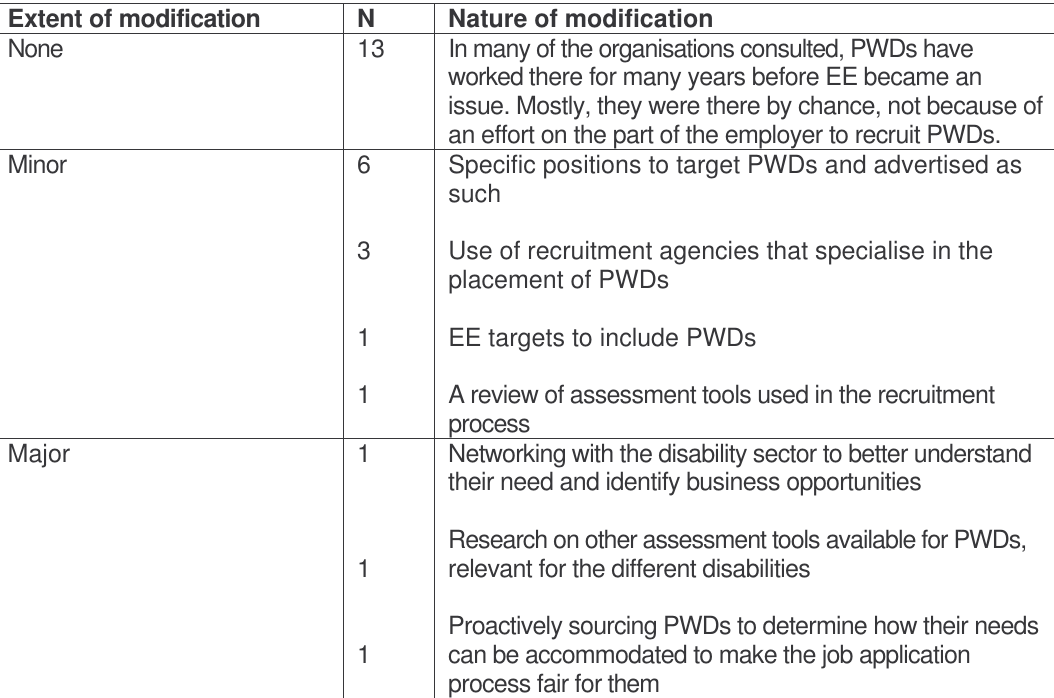
Table 4: Recruitment and